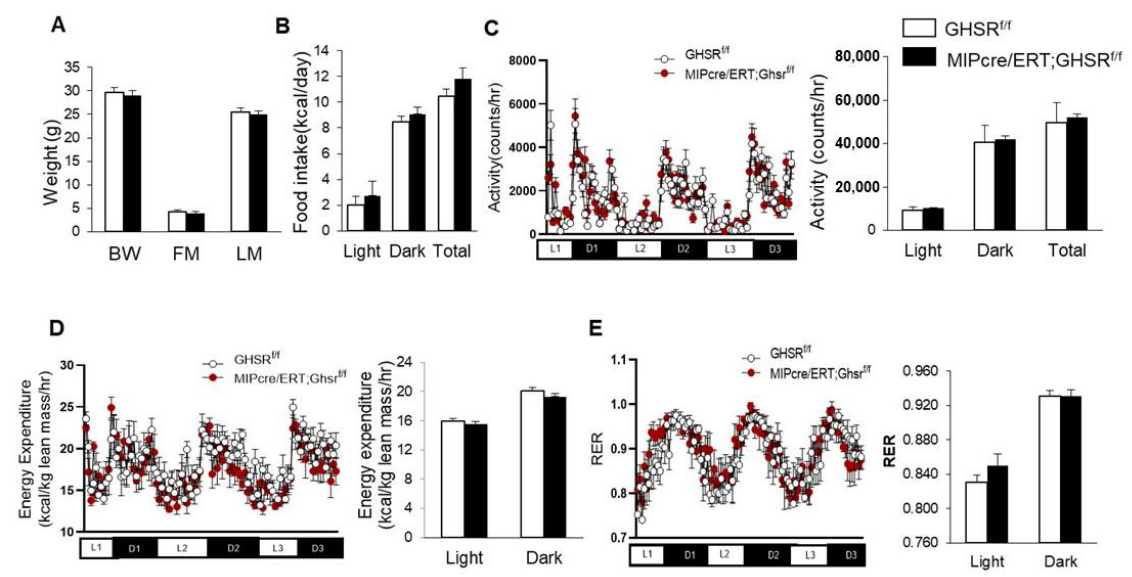
Figure 3. GHS-R ablation in β cells had no impact on body weight and metabolic profile . Five-to-five-point-five-month- old Ghsr f/f and MIP-CreERT;Ghsr f/f mice were subjected to the analysis of the comprehensive laboratory animal monitoring system. Metabolic parameters shown as column graphs were an average of 3-day recordings. ( A ) Body composition (BW: body weight, FM: fat mass, LM: lean mass); ( B ) food intake; ( C ) locomotor activity; ( D ) energy expenditure normalized by lean weight; ( E ) respiratory exchange ratio. n = 4 .